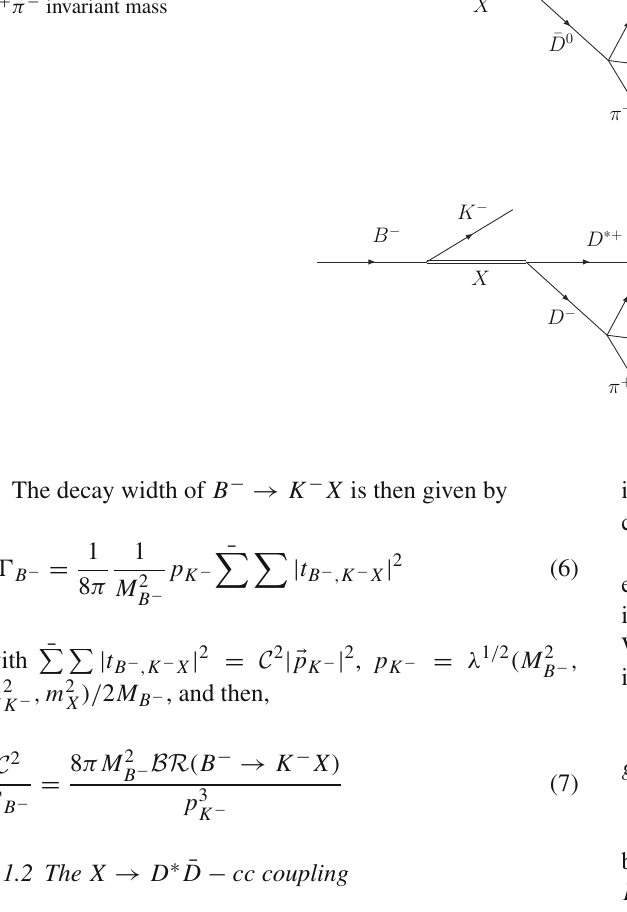
Fig. 2 Mechanisms for B − → K − X ; X → π 0 π + π − which develop a TS in the π + π − invariant